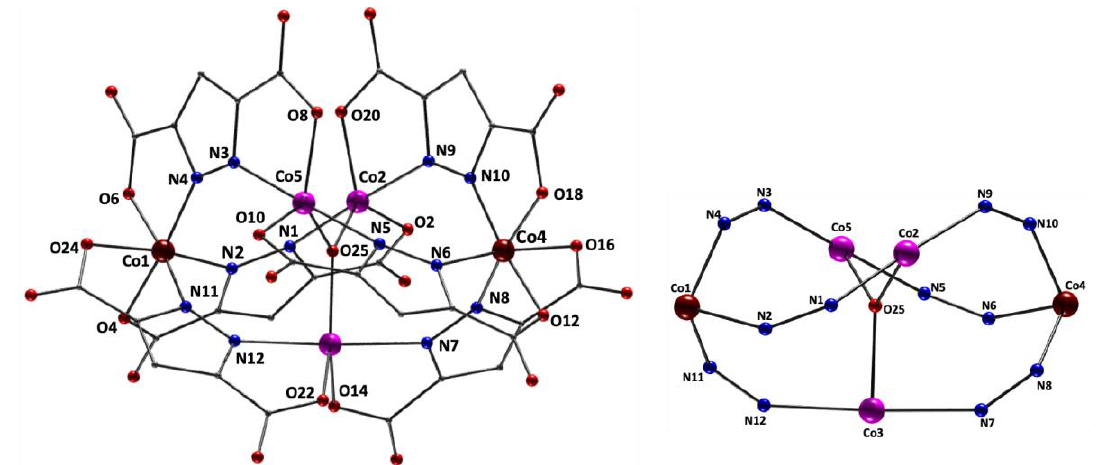
Figure 3. Representation of the molecular structure of 3 ( left ) and the trigonal pipyramidal metal topology of its structural core ( right ). Colour code: Co II , pink.; Co III , dark red; N, blue; O, red; C, grey.